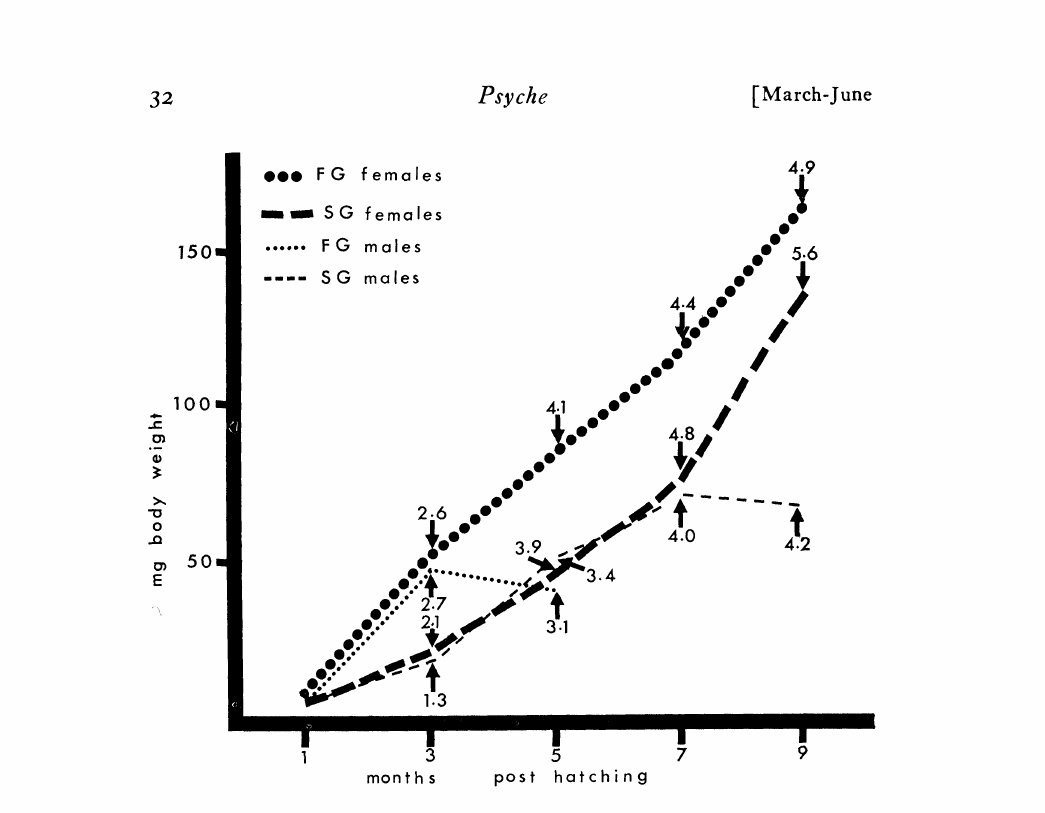
Figure 6. Body weight and number of mol’ts of 25 males (15 FG, 10 SG), and 25 females (15 FG, 10 SG) from the two sets cocoons of draneus diadematus studied. Each line connects mean body weights at one, two, five, seven and nine months pest-hatching. Large black circles: FG females, large dashed line: early life of SG females; small black circles: FG males, small dashed line: SG males. Arrows indicate the number of molts to. the time. Note the different growth rates and the related different speed of maturation in FG and SG males and females, and the similarities for both